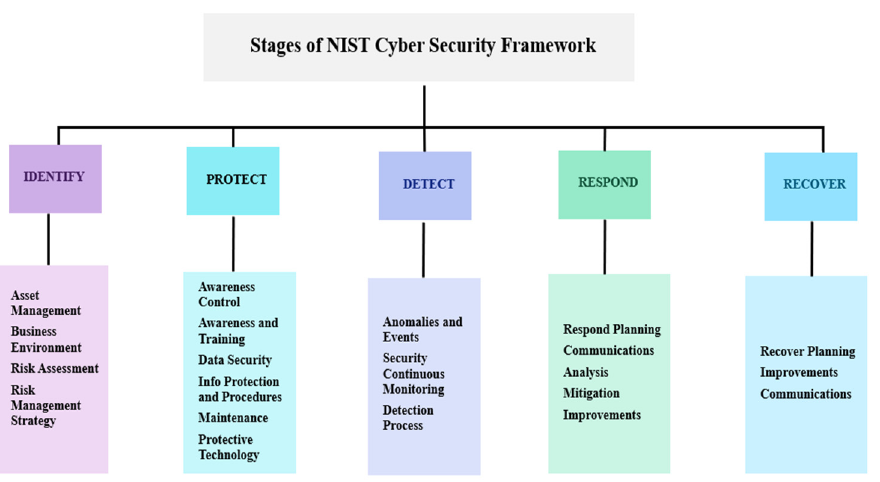
Figure 13. NIST Cybersecurity Framework (based on NIST model ) [68] .